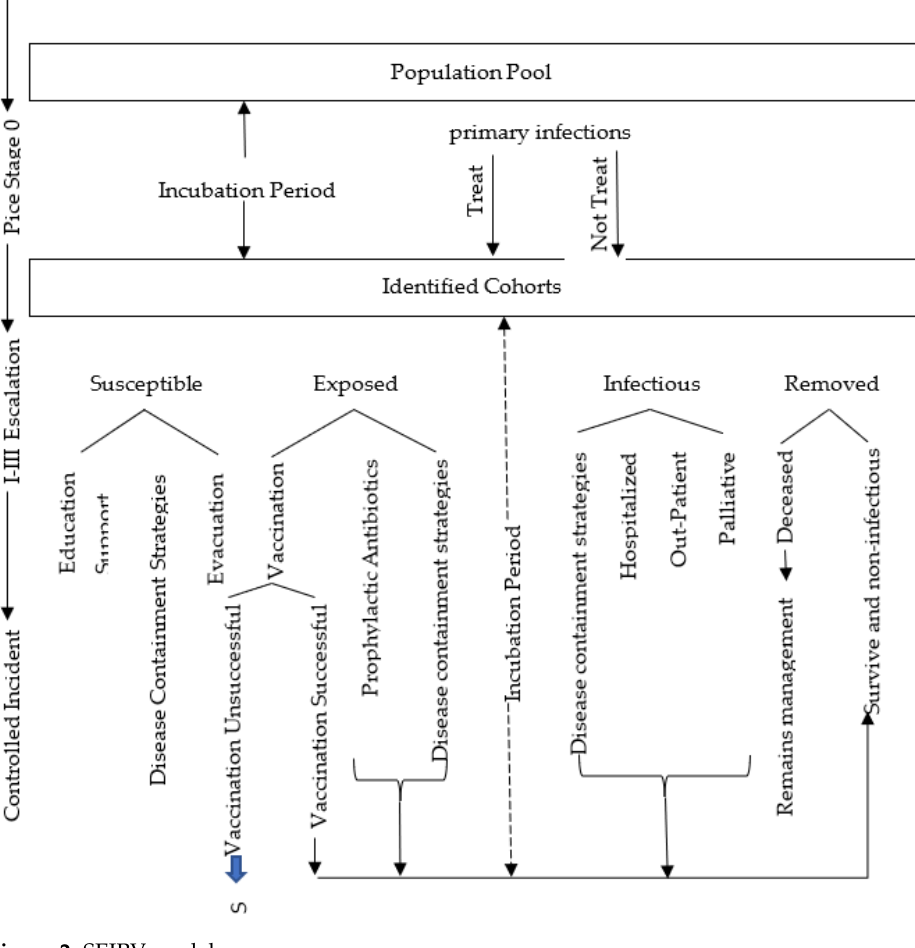
Figure 2. SEIRV model.